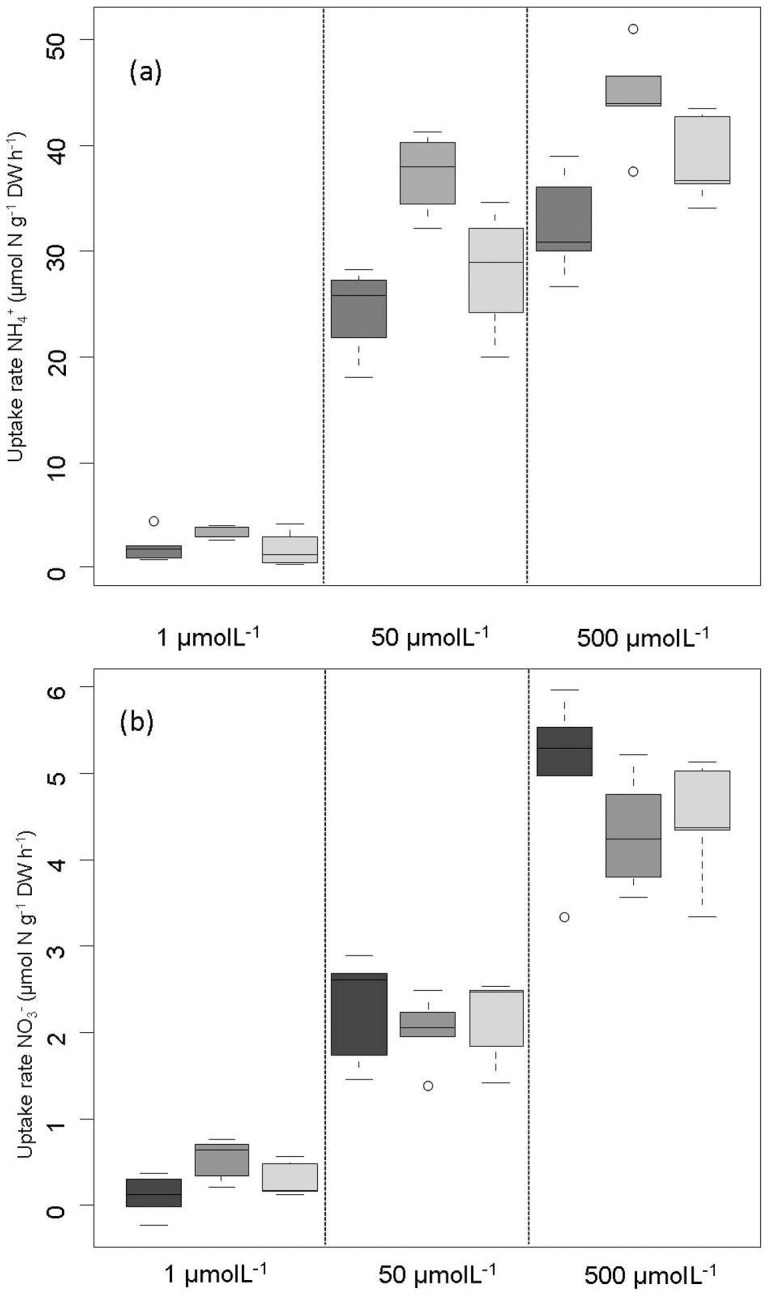
Differences between average uptake rates (µmol N gDW−1 h−1) after 0.5 hours in different fractions of Sphagnum magellanicum from the pristine site.We analysed capitula and stems separately, while whole plant values represent the DW weighted mean of both fractions.